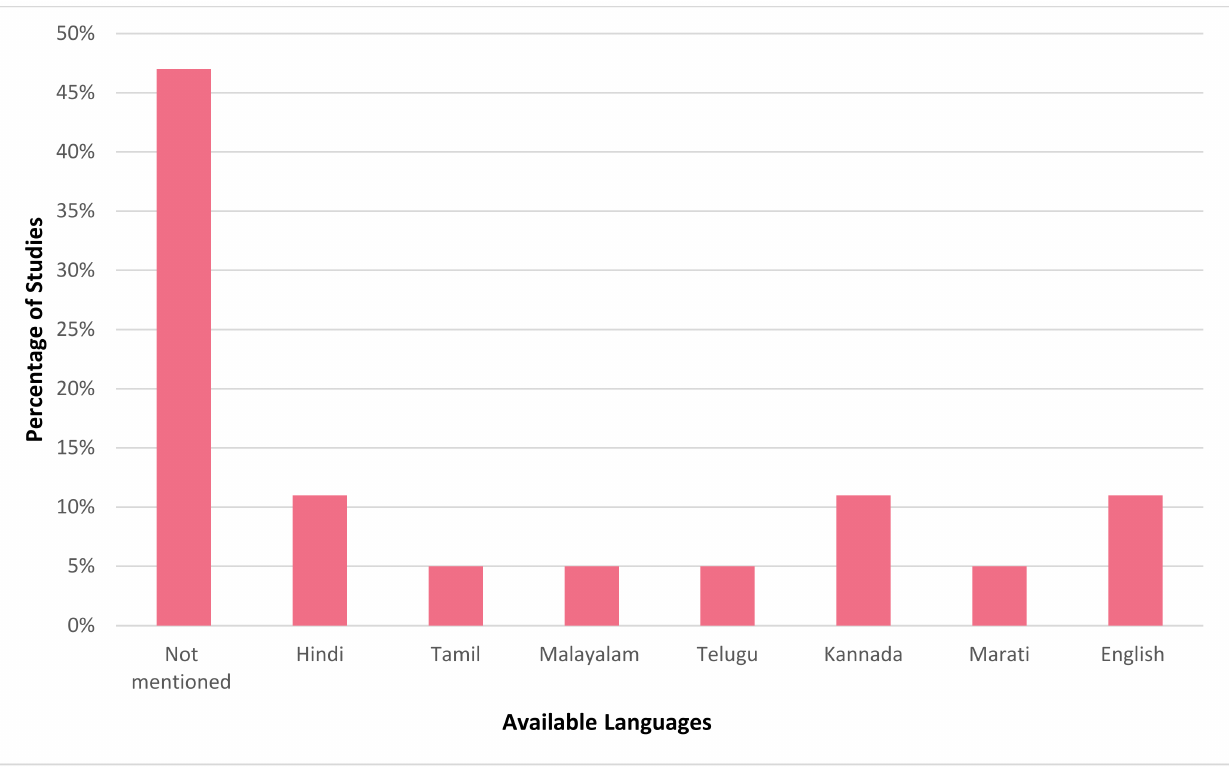
Figure 6. Predominant language in which the mHealth interventions chosen for this study that was available for